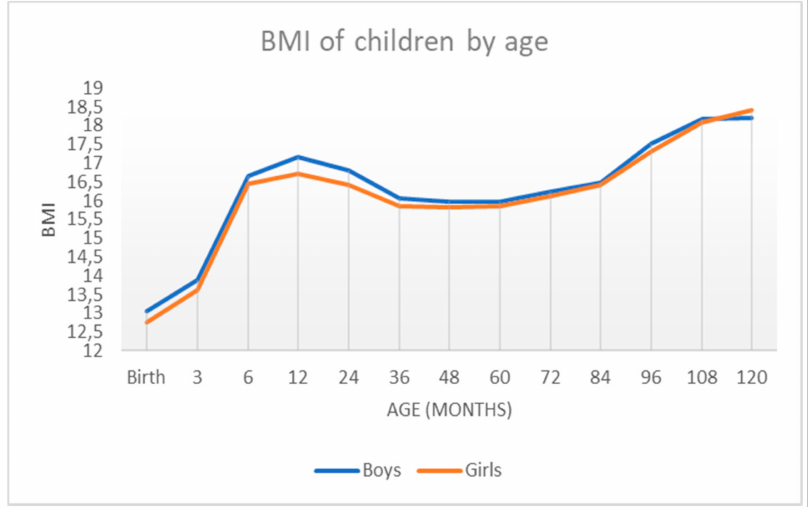
Figure 8. BMI in boys and girls according to